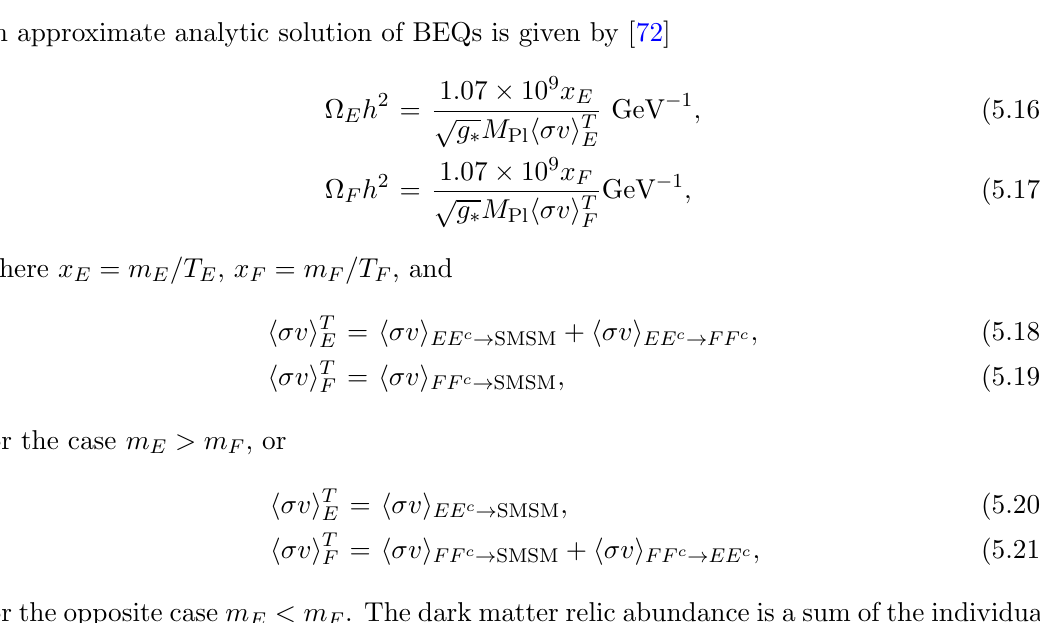
Figure 4 . The total relic density contoured as a function of ( m stable regime is also included, according to the several choices of w; V